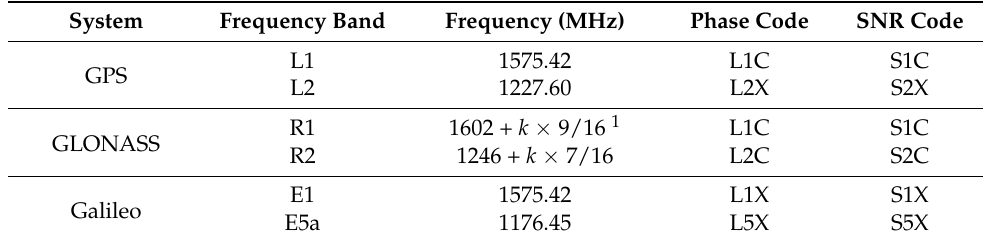
Table 1. Specific parameters of GNSS observation for multi-constellation satellites received by two GNSS receivers.